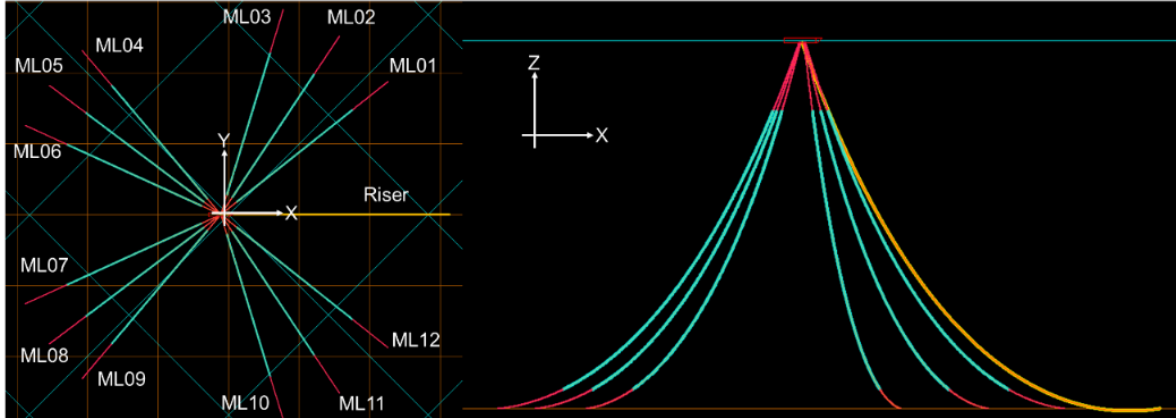
Figure 8. Current Profile, 1-yr and 100-yr Cases.